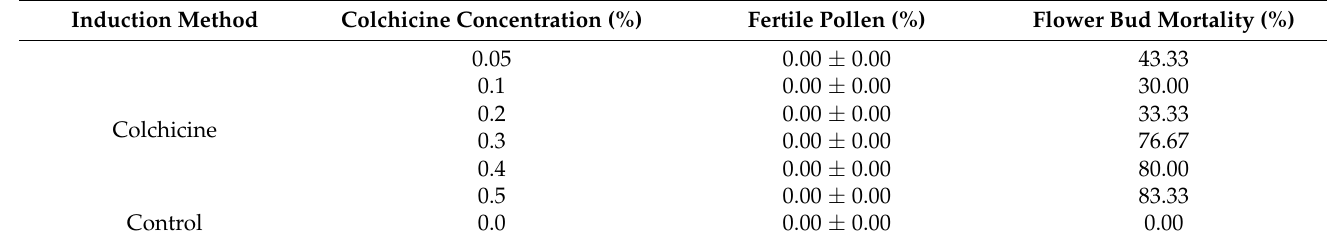
Table 5. Effects of colchicine with different concentrations on fertile pollen induction for ‘Black Beauty’.